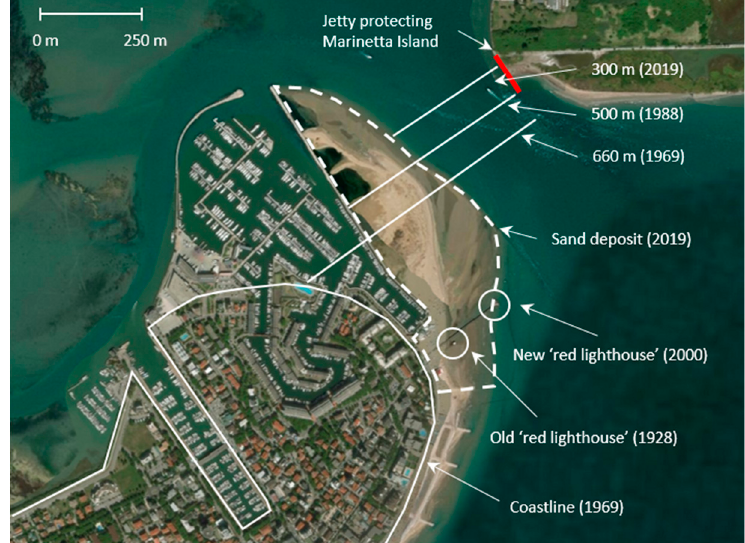
Figure 3. Detailed pictures of the Lignano tidal inlet: the current sand deposit delineated by the dotted line, the old and the current lighthouses in the circles and width of the inlet section over the years.